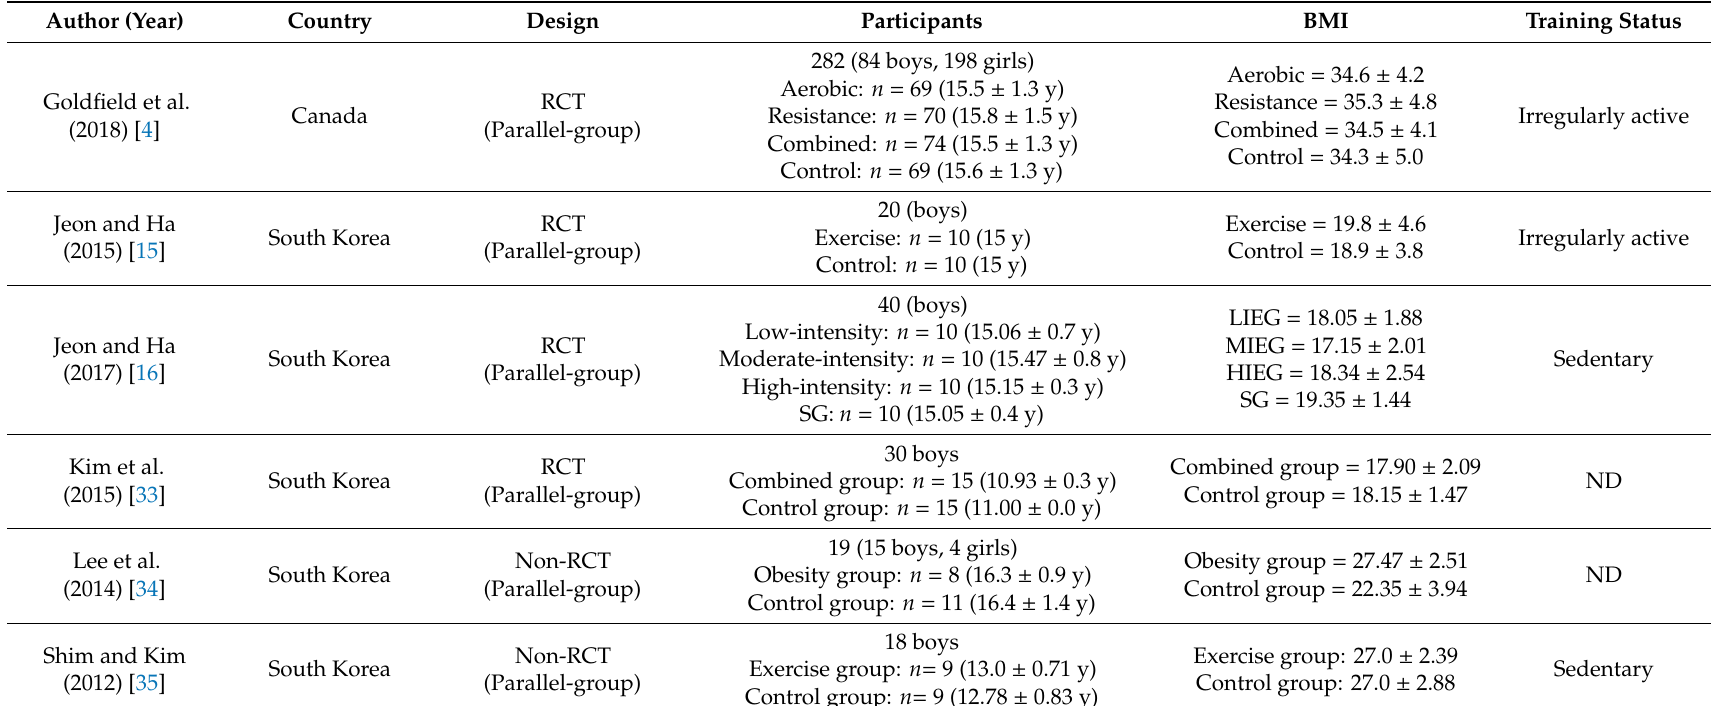
Table 1. Characteristics of the studies